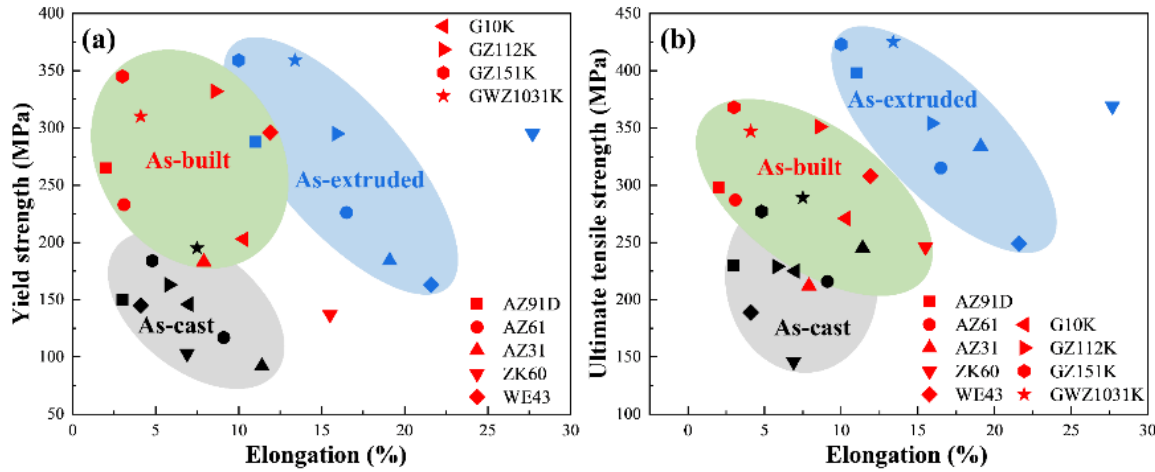
Figure 10. Comparison of room temperature tensile properties of the typical Mg alloys under the as-cast, as-built and as-extruded states ( a ) YS vs. EL, ( b ) UTS vs. EL. Reprinted with permission from ref. [74]. Copyright 2022 Chinese Academy of Sciences.